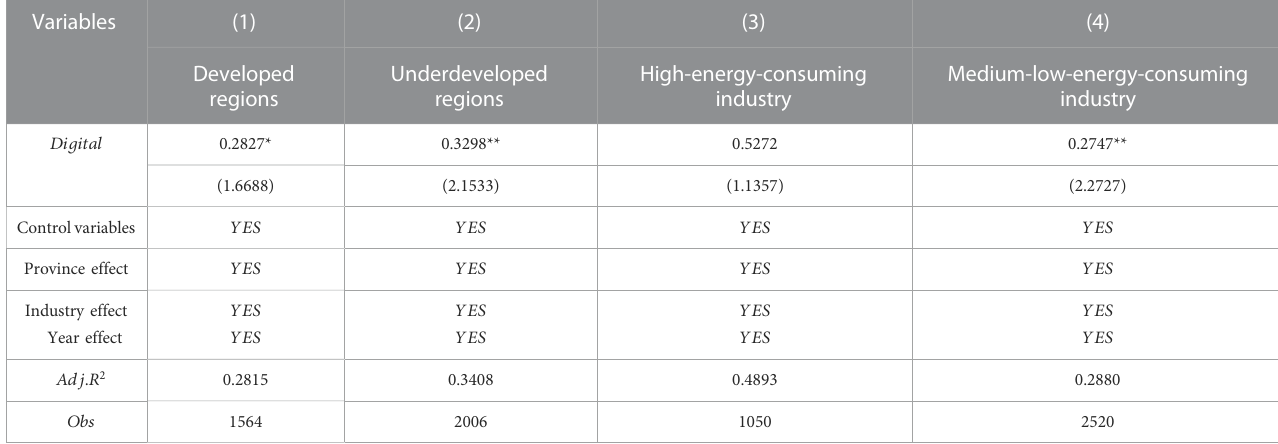
TABLE 8 Results of heterogeneity analysis.